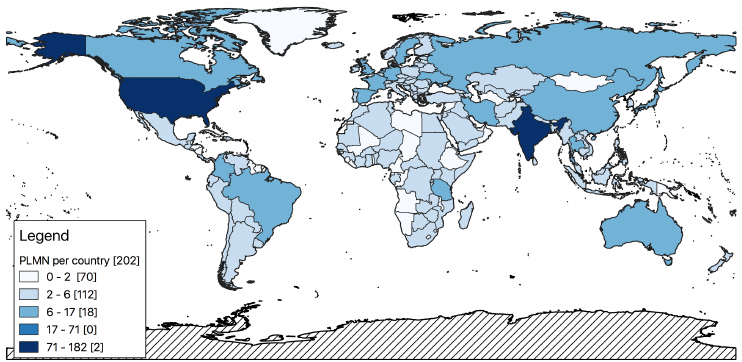
Figure 12. Number of PLMNs per country.